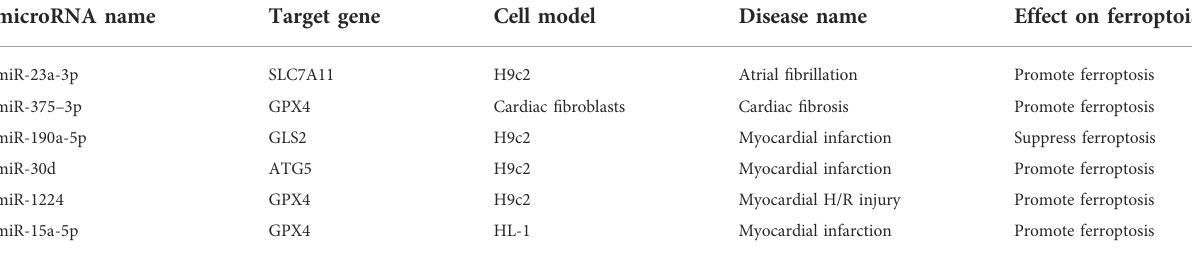
TABLE 1 The role of microRNA in cardiomyopathy via regulating